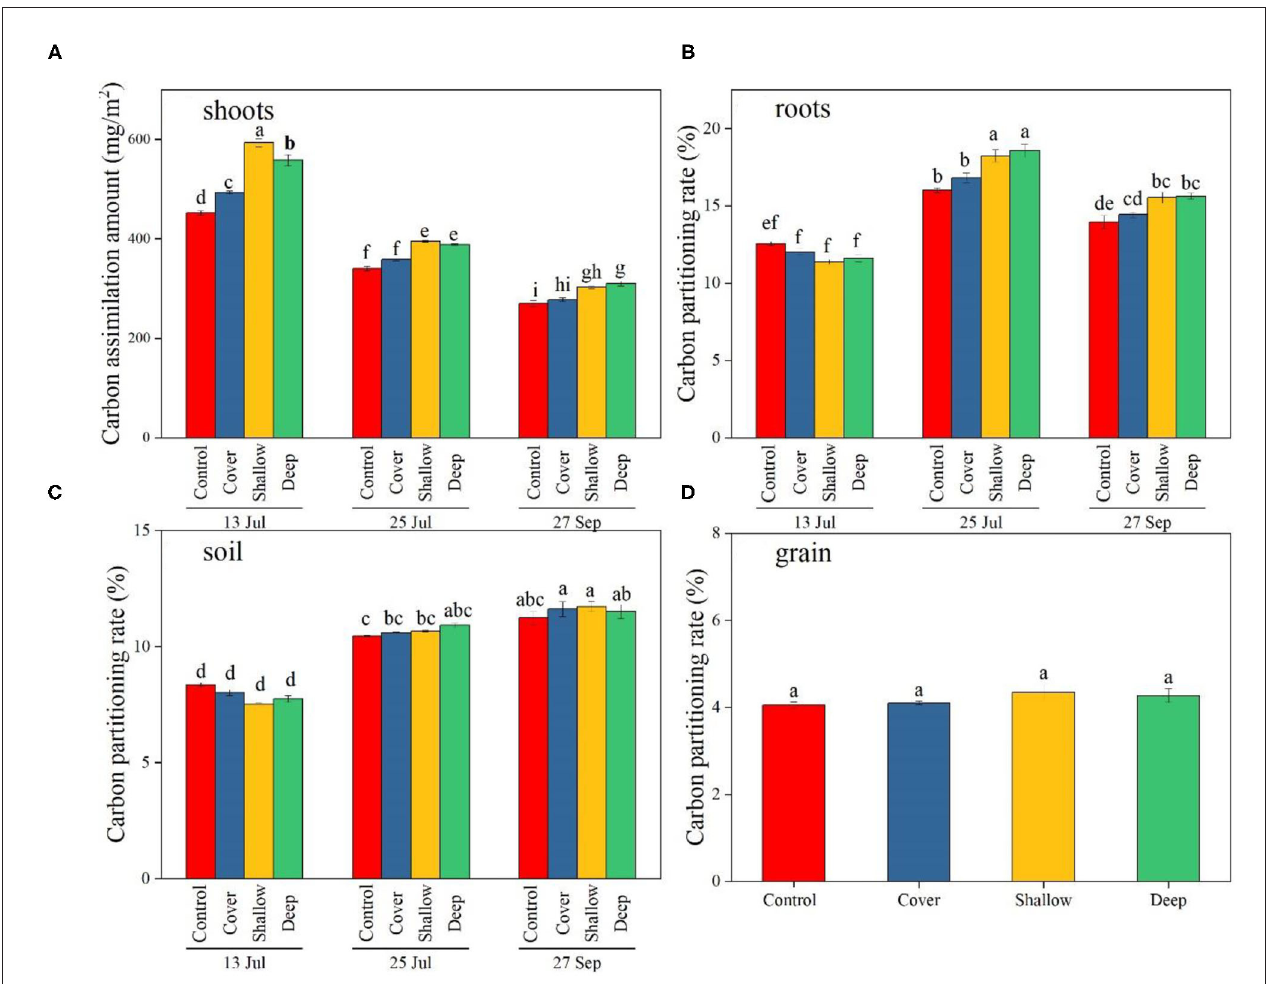
FIGURE 3 | The amount of photosynthetic carbon ( 13 C) accumulated in maize shoots (A) and partitioning of photosynthetic carbon ( 13 C) to maize roots (B) , 0–40cm soil (C) , and grain (D) on the three sampling dates [13 Jul: early jointing, 62 days after sowing (DAS); 25 Jul: late jointing, 74 DAS; 27 Sep: grain maturity, 138 DAS]. Carbon partitioning: 13 C content of individual plant parts or soil divided by the sum of 13 C fixed ( 13 C found in the shoots, roots, soils and grains) (expressed as %). Means ± SE ( n = 3). Different letters denote significant differences among sampling dates × treatments (A–C) or among treatments (D) ( P < 0.05). Control, no straw added; Cover, straw added to the soil surface; Shallow, straw incorporated at the 0–20cm soil depth; Deep, straw incorporated at the 20–40cm soil